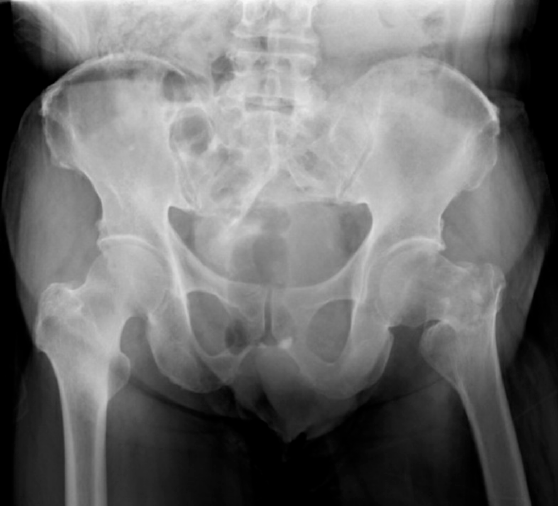
Figure 1. AP radiograph of the pelvis, showing left basicervical peritrochanteric fracture with displacement and varus angulation.